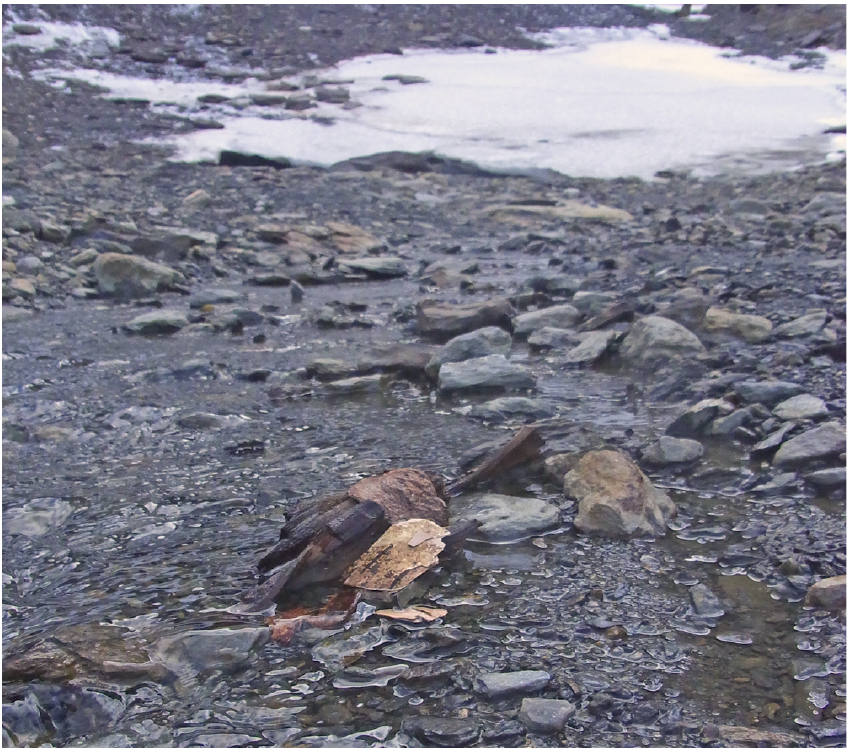
Figure 41: Kärkerieppeglaciären (10). Parts of a birch stem with large bark fragments preserved. 5310 cal. yr BP (Beta-284460).